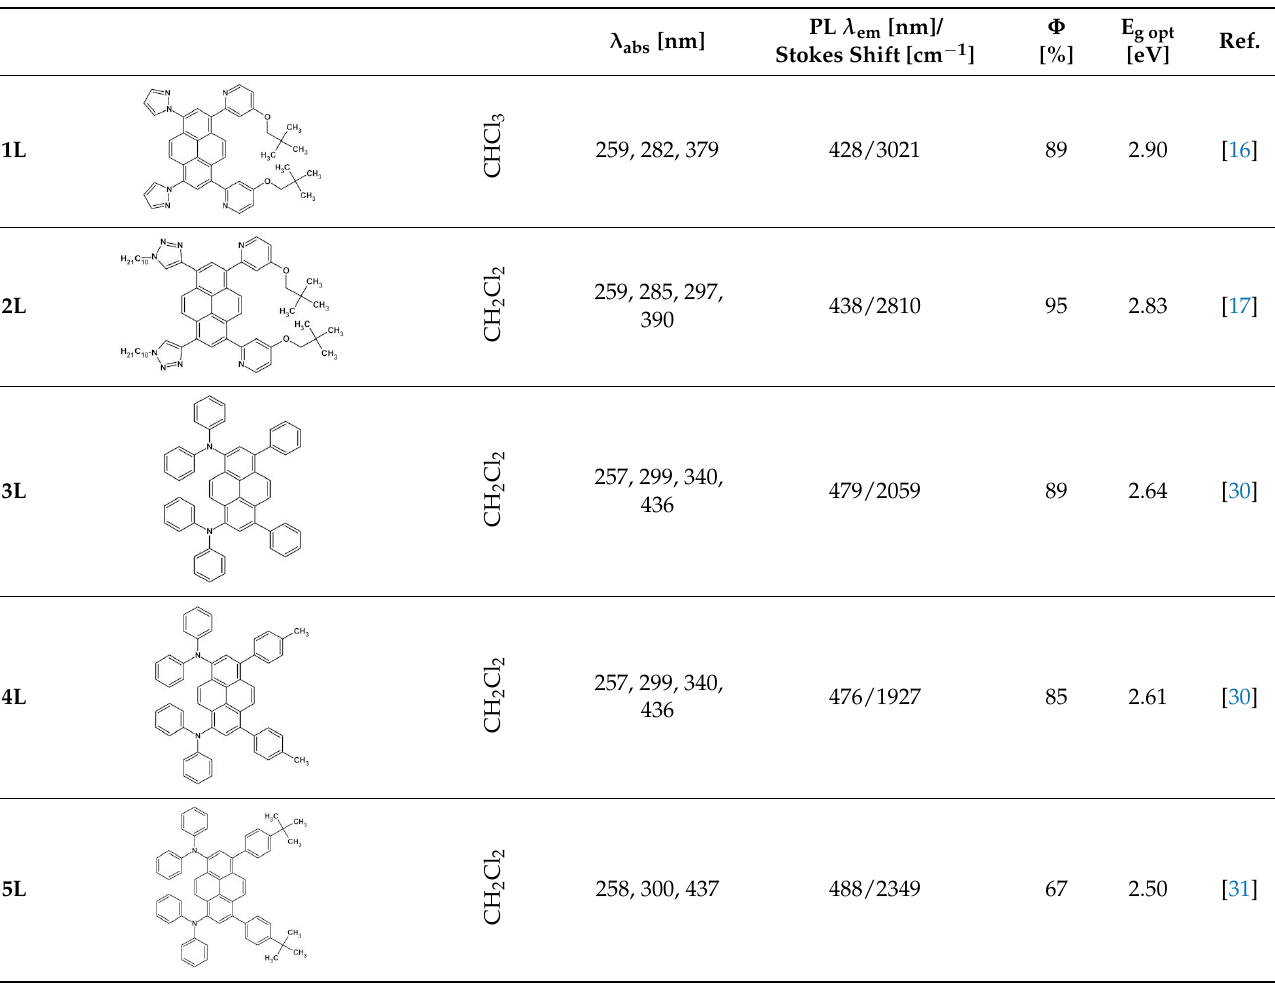
Table 8. Photophysical and optical data recorded in the solution (CHCl 3 or CH 2 Cl 2 ) ( c = 10 − 5 mol/L) of the 1,3,6,8-tetrasubstituted pyrene substituted by two kinds of substituents with the substitution pattern providing the long axial symmetry reported in the literature.